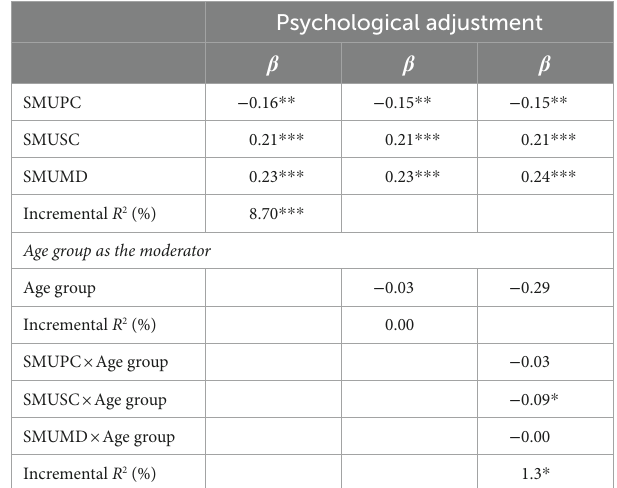
TABLE 4 Coefficients of regression analysis predicting psychological